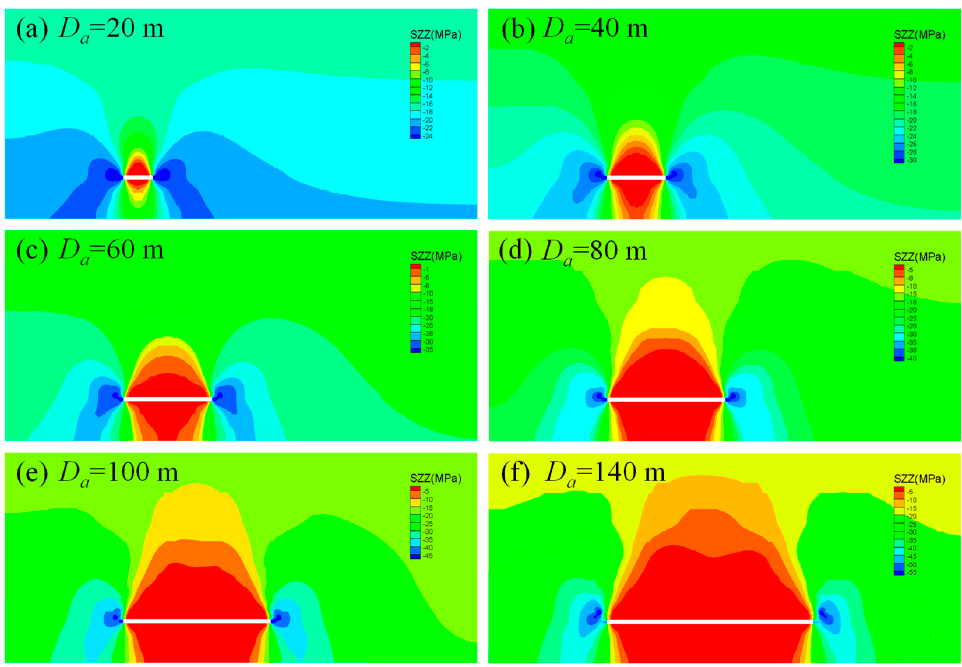
Figure 4. Vertical stress evolution as the working face advances from 20 to 140 m.